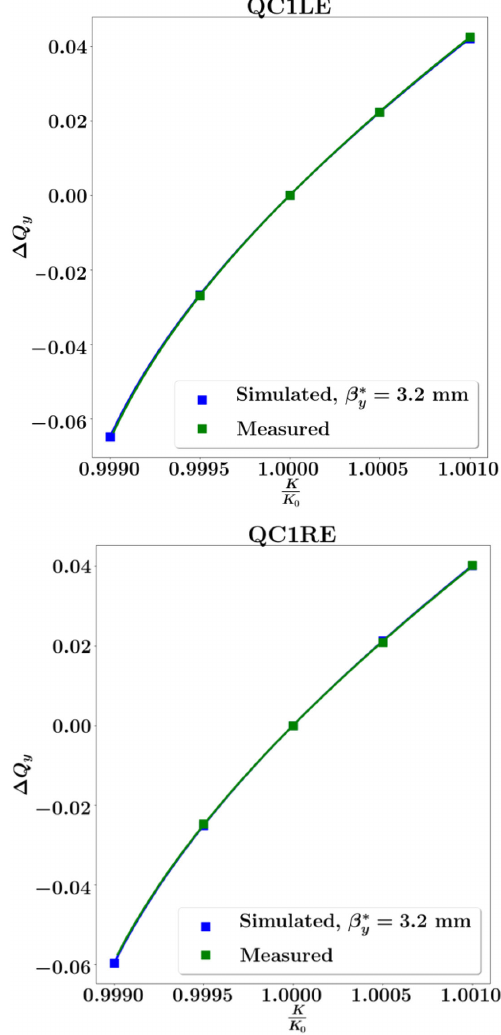
FIG. 12. Histograms showing the number of BPMs measuring a certain value of the tune. Three sets of turn by turn measurements were recorded for each setting of the two magnets QC1LE and QC1RE. The colors indicate the sequence of the measurements; blue being first, followed by orange, and green last. The histo- grams on the left column come from the reference measurements for the magnets with Δ KL ¼ 0 , while in the ones on the right column have Δ KL=KL ¼ 0 . 05% . The integrated strength of the magnets during the measurements were KL 0 ¼ − 1 . 15 m − 1 for QC1LE and KL 0 ¼ − 1 . 09 m − 1 for QC1RE.